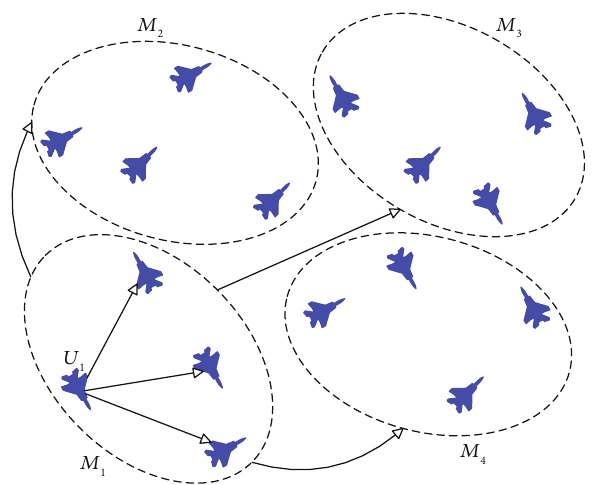
Figure 3: The communication mode in the consensus process in the two-layer algorithm.